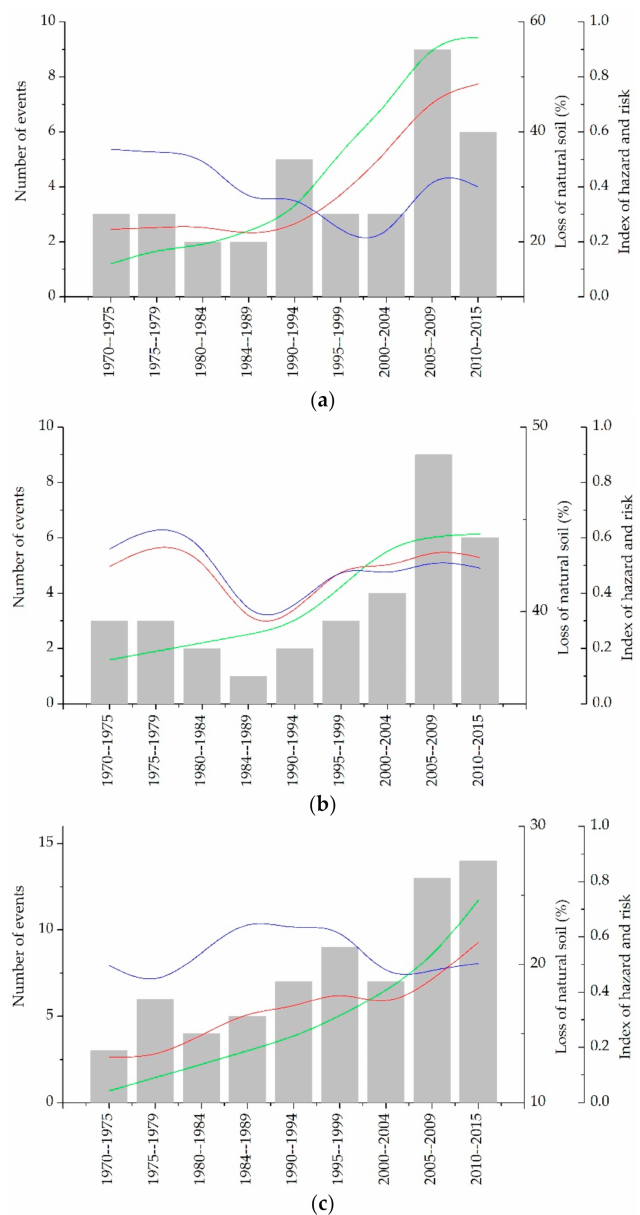
Figure 6. Hazard index P95 for intense daily precipitation events (blue line) for five years period. Vulnerability associated with the loss of natural vegetation (green line) for the same periods and the corresponding risk index (red line). Number of flood events (gray bar). ( a ) in the northern region (Panuco), ( b ) in the central region (Papaloapan) and ( c ) in the southern region (Coatzacoalcos) in Veracruz state,